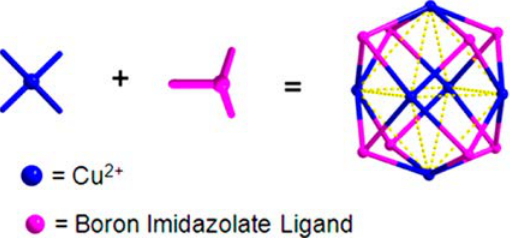
Figure 4. Principle of self-assembly of the dodecahedral cage (M 6 L 8 ). Reprinted with permission from Reference 45.